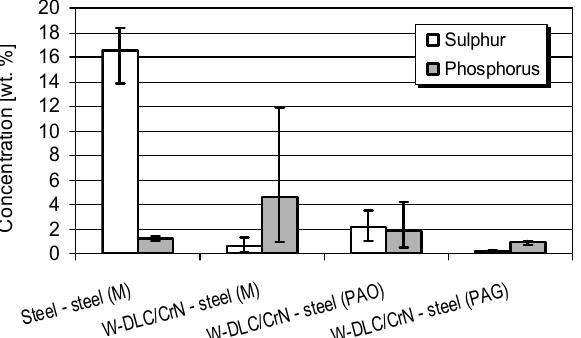
Figure 12. Quantitative results of the EDS analysis of the sulfur and phosphorus from the worn surfaces of the vee blocks.